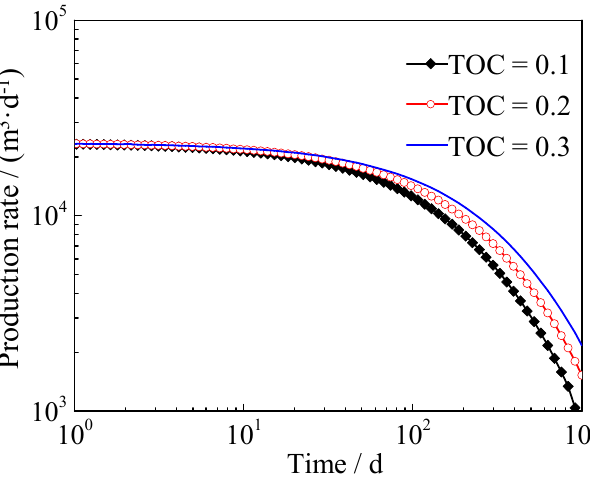
Figure 6. Influence of the total organic content (TOC) on the gas flow rate in shale gas reservoirs .